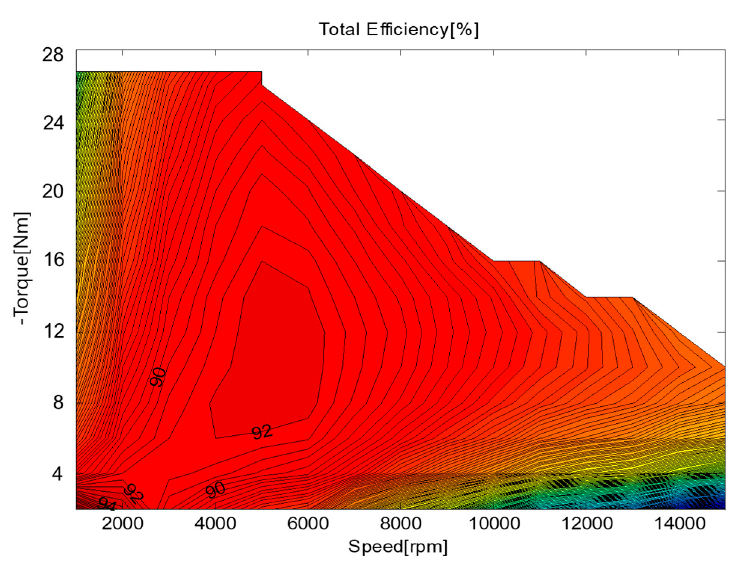
ffi ciency of the target motor drive. Figure 10. Efficiency of the target motor drive. Figure 10. E Figure 10. Efficiency of the target motor drive.